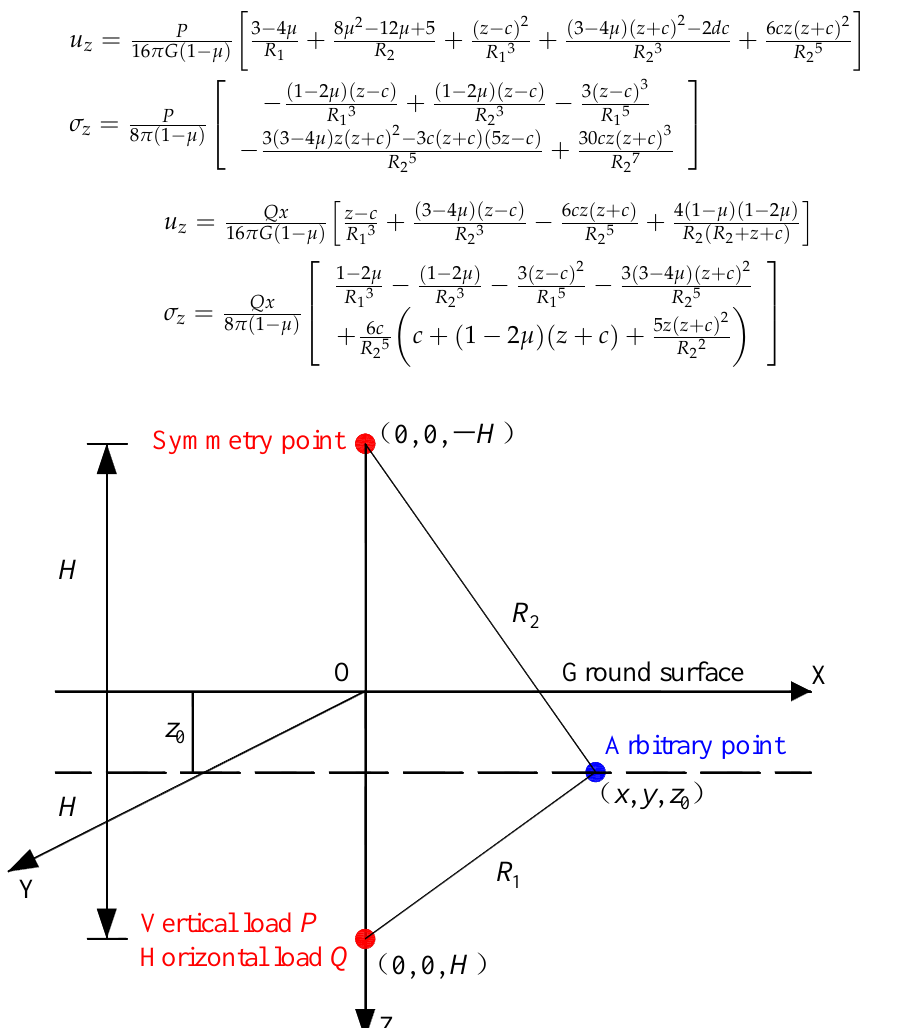
Figure 3. A vertical load or horizontal load in the interior of an elastic half-space. Integrating Mindlin’s solutions can represent the free-field movements induced by different force patterns. As shown in Figure 4, the force patterns consist of the support pressure at the tunnel face, the frictional force of the shield shell, and the torsional force of the cutter head. The analytical solutions of these three force patterns are as follows: